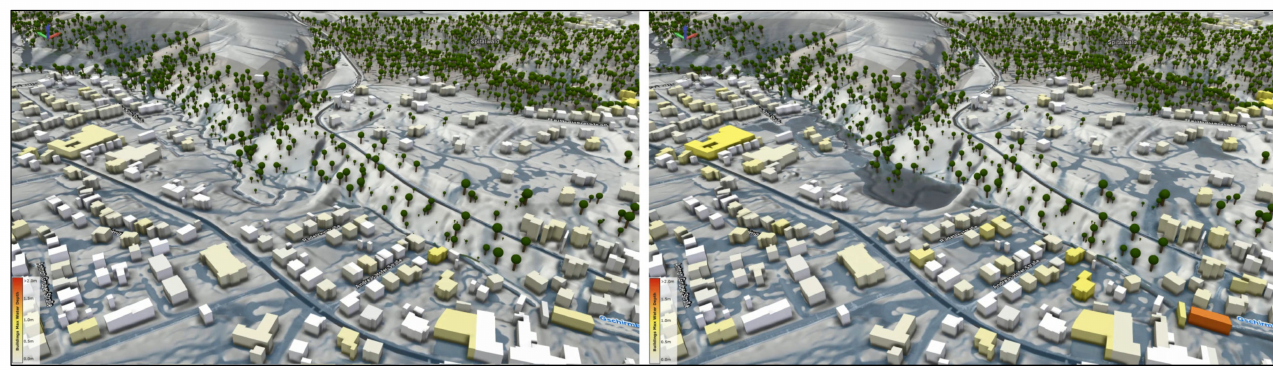
Figure 10. Time-sensitive urban flooding simulation under a heavy rainfall scenario with hazard representation for potential building structural damage (red = high, yellow = medium): earlier time stamp ( left ); later time stamp ( right ).